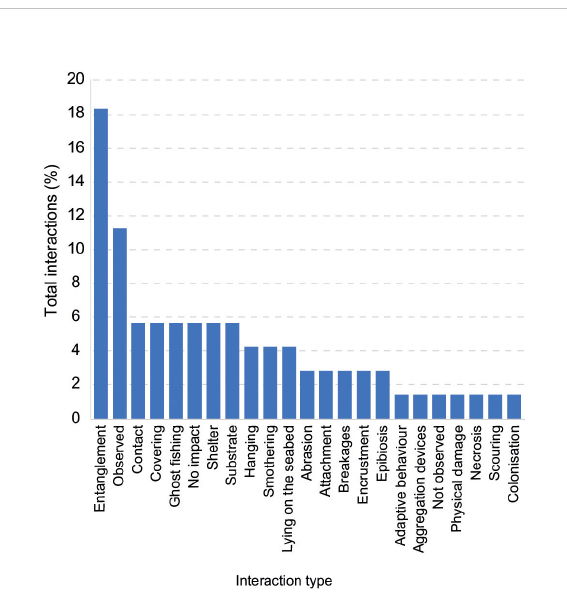
FIGURE 8 Instances of litter interactions (n=71) listed in the literature (25 out of 86 total